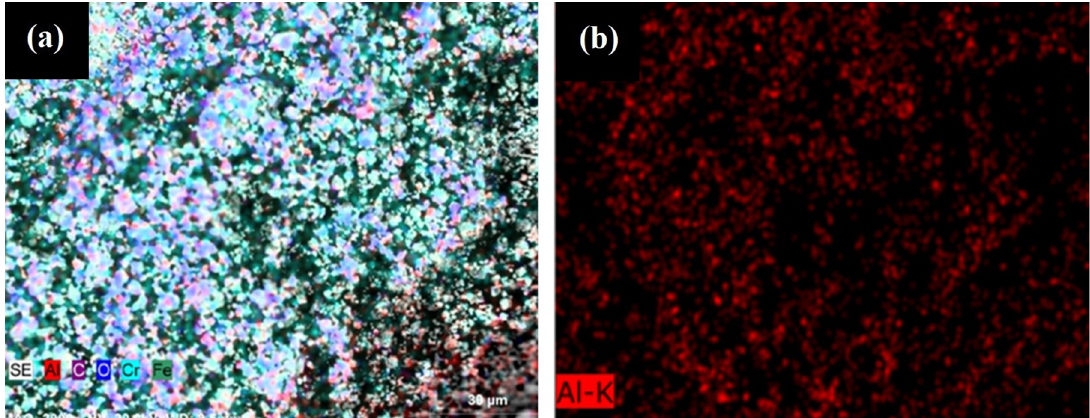
Figure 7. Mapping of the AISI 52100 steel with 3% of alumina (a) Mainly chemical elements of the AISI 52100 steel (b) Alumina particles